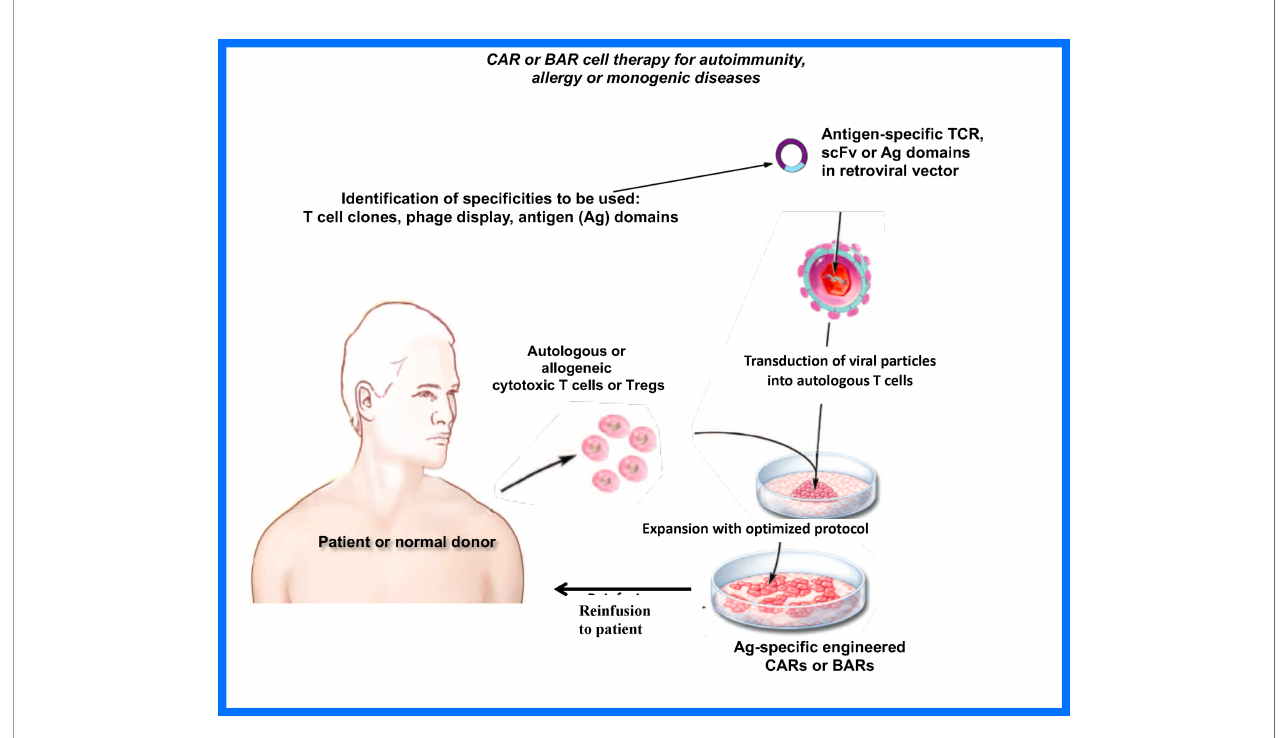
FIGURE 4 | Proposed engineered Treg therapy in